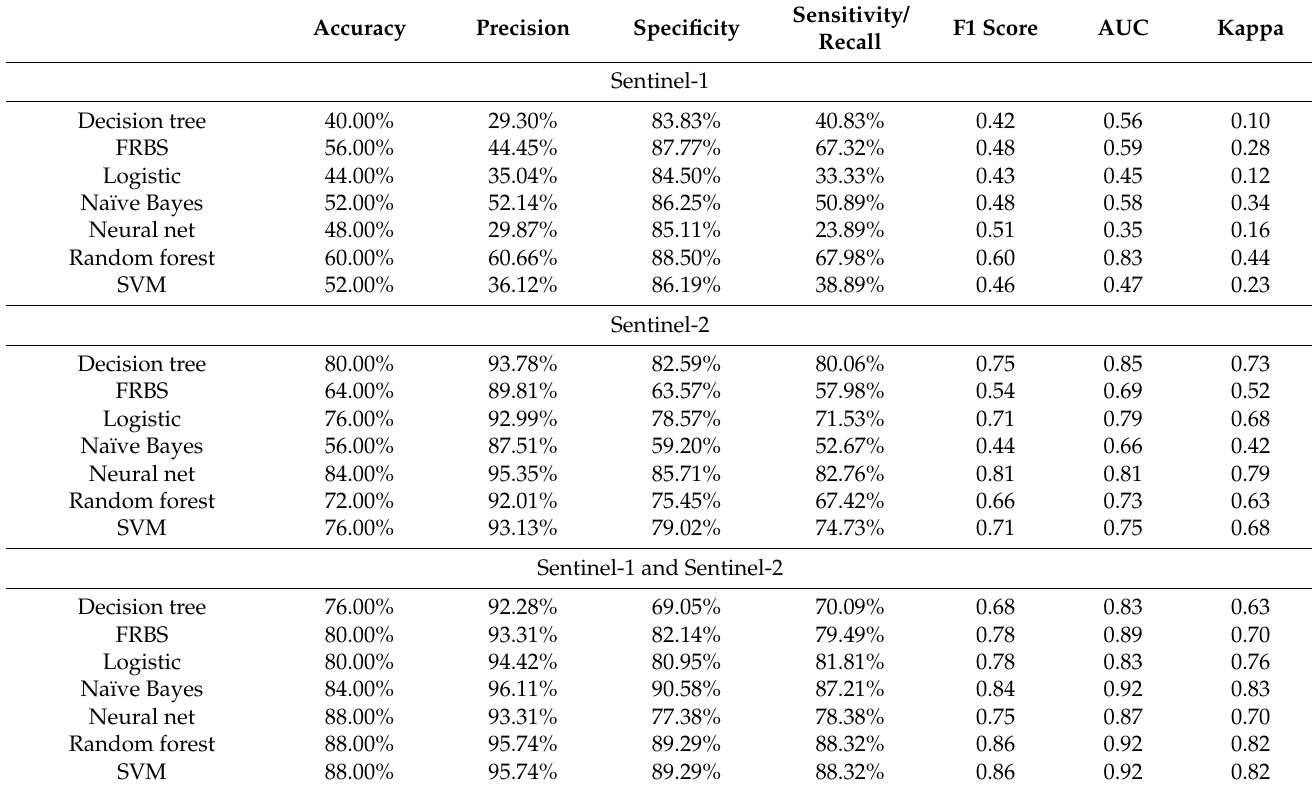
Table 2. Performance metrics of classification